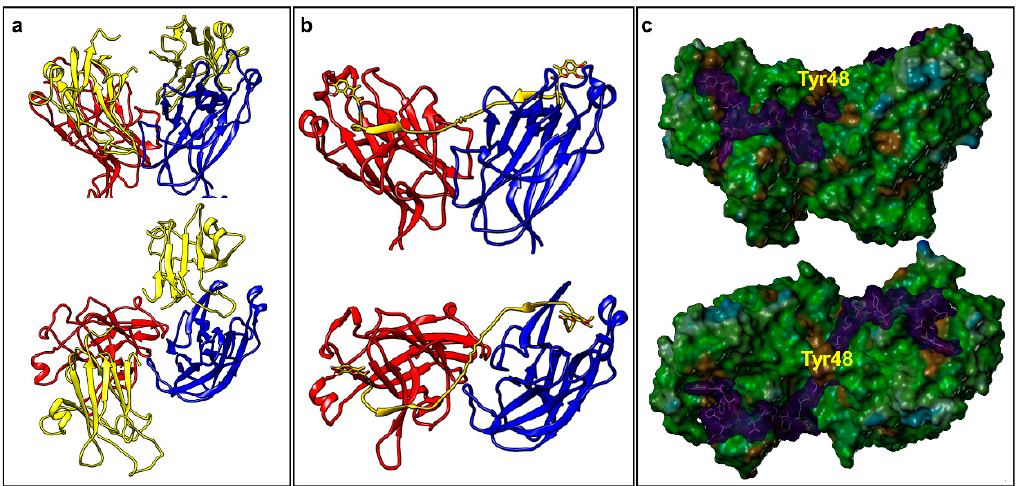
Figure 1. Molecular models of EphA2-LBD in complex with its agonistic agents. ( a ) Front view and top view of the molecular models representing the biological dimeric unit of EphA2-LBD (red and blue), in complex with ephrinA5 (yellow) (PDB ID 3MX0). ( b ) Front view and top view of the molecular model of 135H12 (yellow; Table 1) in complex with EphA2-LBD (red and blue). The model was build based on the dimeric biological unit of EphA2-LBD in complex with 135E2 (Table 1; PDB ID 6B9L). ( c ) Molecular surface representation of the models shown in ( b ) generated with MOLCAD (Sybyl-X 1.2). 135H12 surface is in magenta, while the surface for EphA2-LBD dimer is color coded according to hydrophobicity (MOLCAD). The position of residue Tyr48, at the bridge between the two monomer, is highlighted.